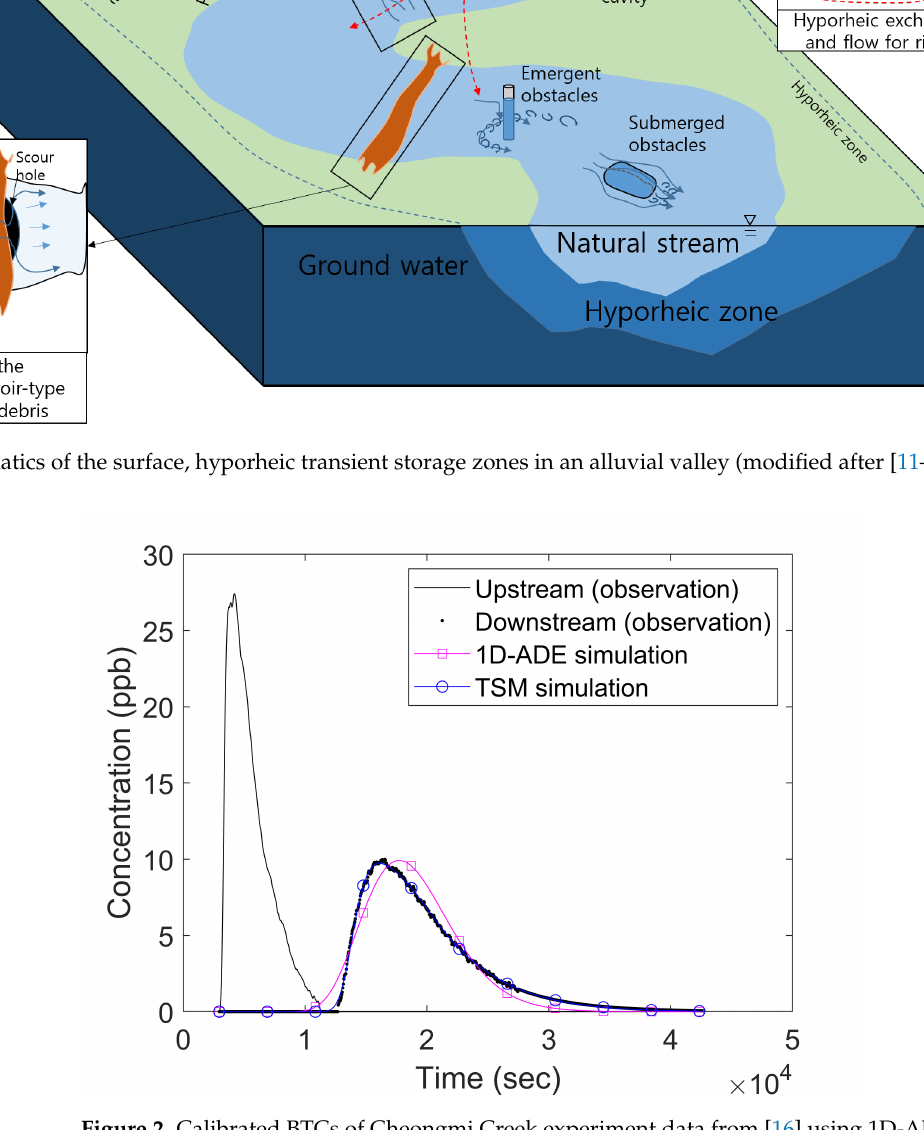
Figure 2. Calibrated BTCs of Cheongmi Creek experiment data from [16] using 1D-ADE and